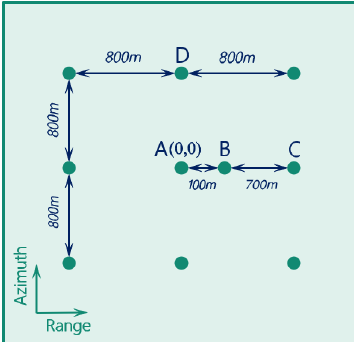
Figure 8. Geometric layout of the points on the ground for